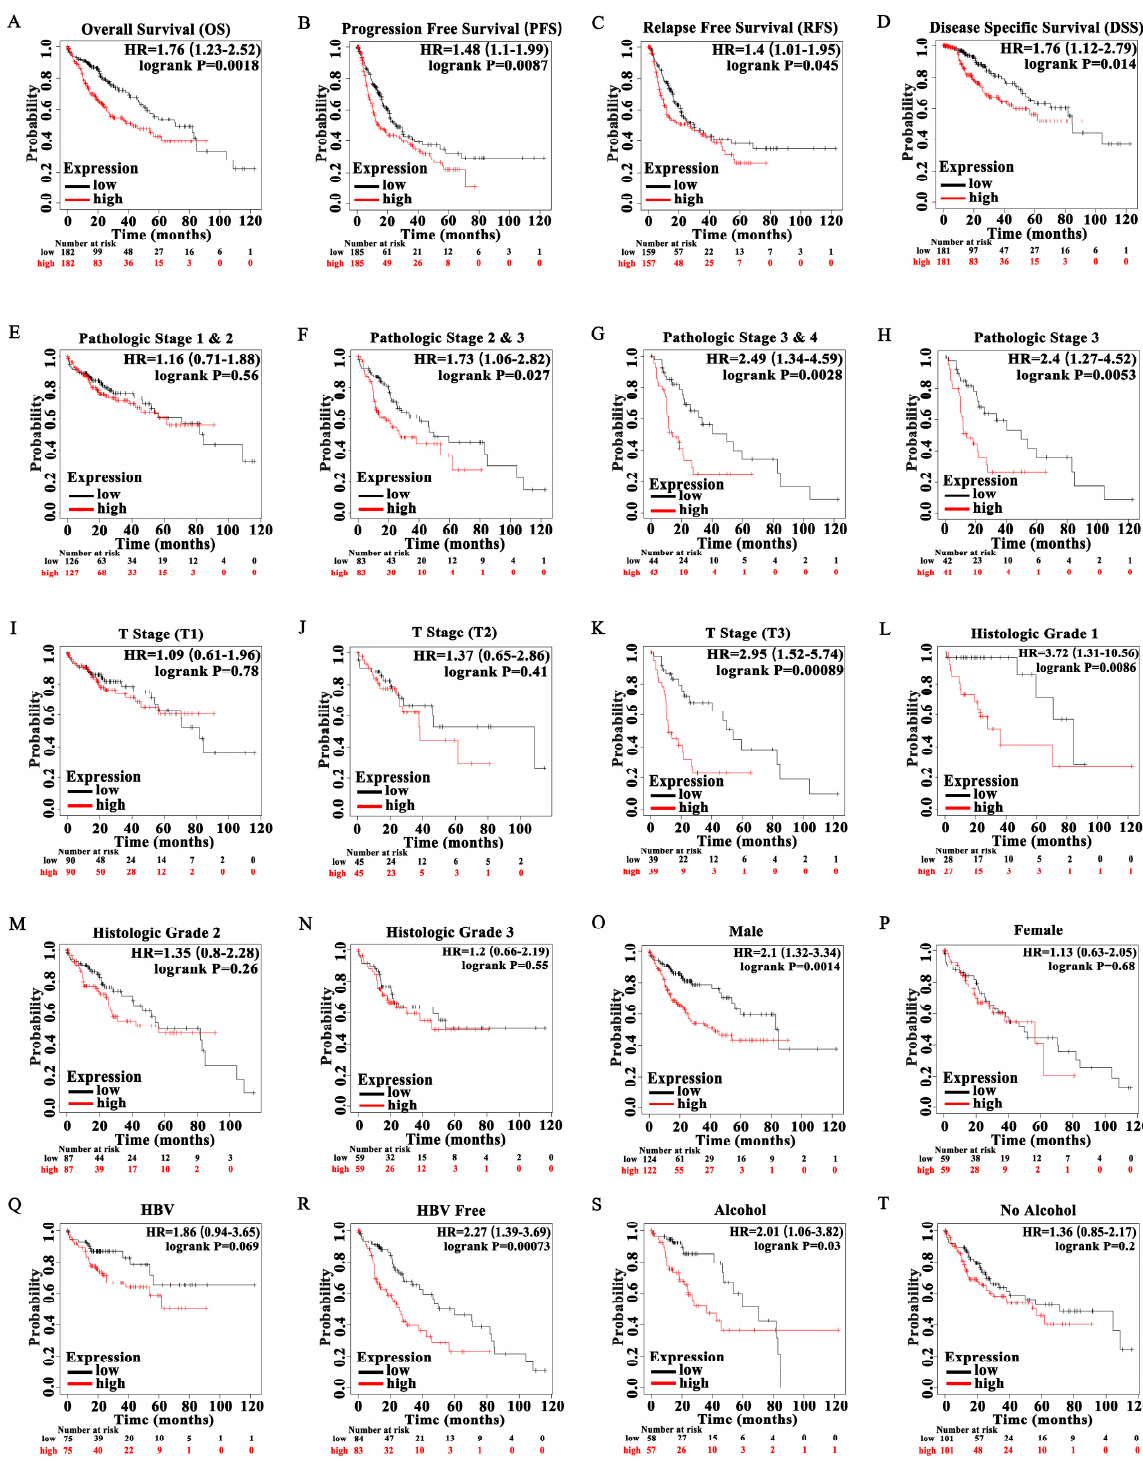
Figure 4. Kaplan-Meier curve for survival in patients with hepatocellular carcinoma according to high and low expression levels of POGK. ( A ) overall survival (OS); ( B ) progression-free survival (PFS); ( C ) relapse-free survival (RFS); ( D ) disease-specific survival (DSS); ( E ) pathologic stage 1 and 2; ( F ) pathologic stage 2 and 3; ( G ) pathologic stage 3 and 4; ( H ) pathologic stage 3; ( I ) T1 stage; ( J ) T2 stage; ( K ) T3 stage; ( L ) histologic grade 1; ( M ) histologic grade 2; ( N ) histologic grade 3; ( O ) male; ( P ) female; ( Q ) with history of HBV infection; ( R ) absence of history of HBV infection; ( S ) with history of alcohol intake; ( T ) absence of alcohol